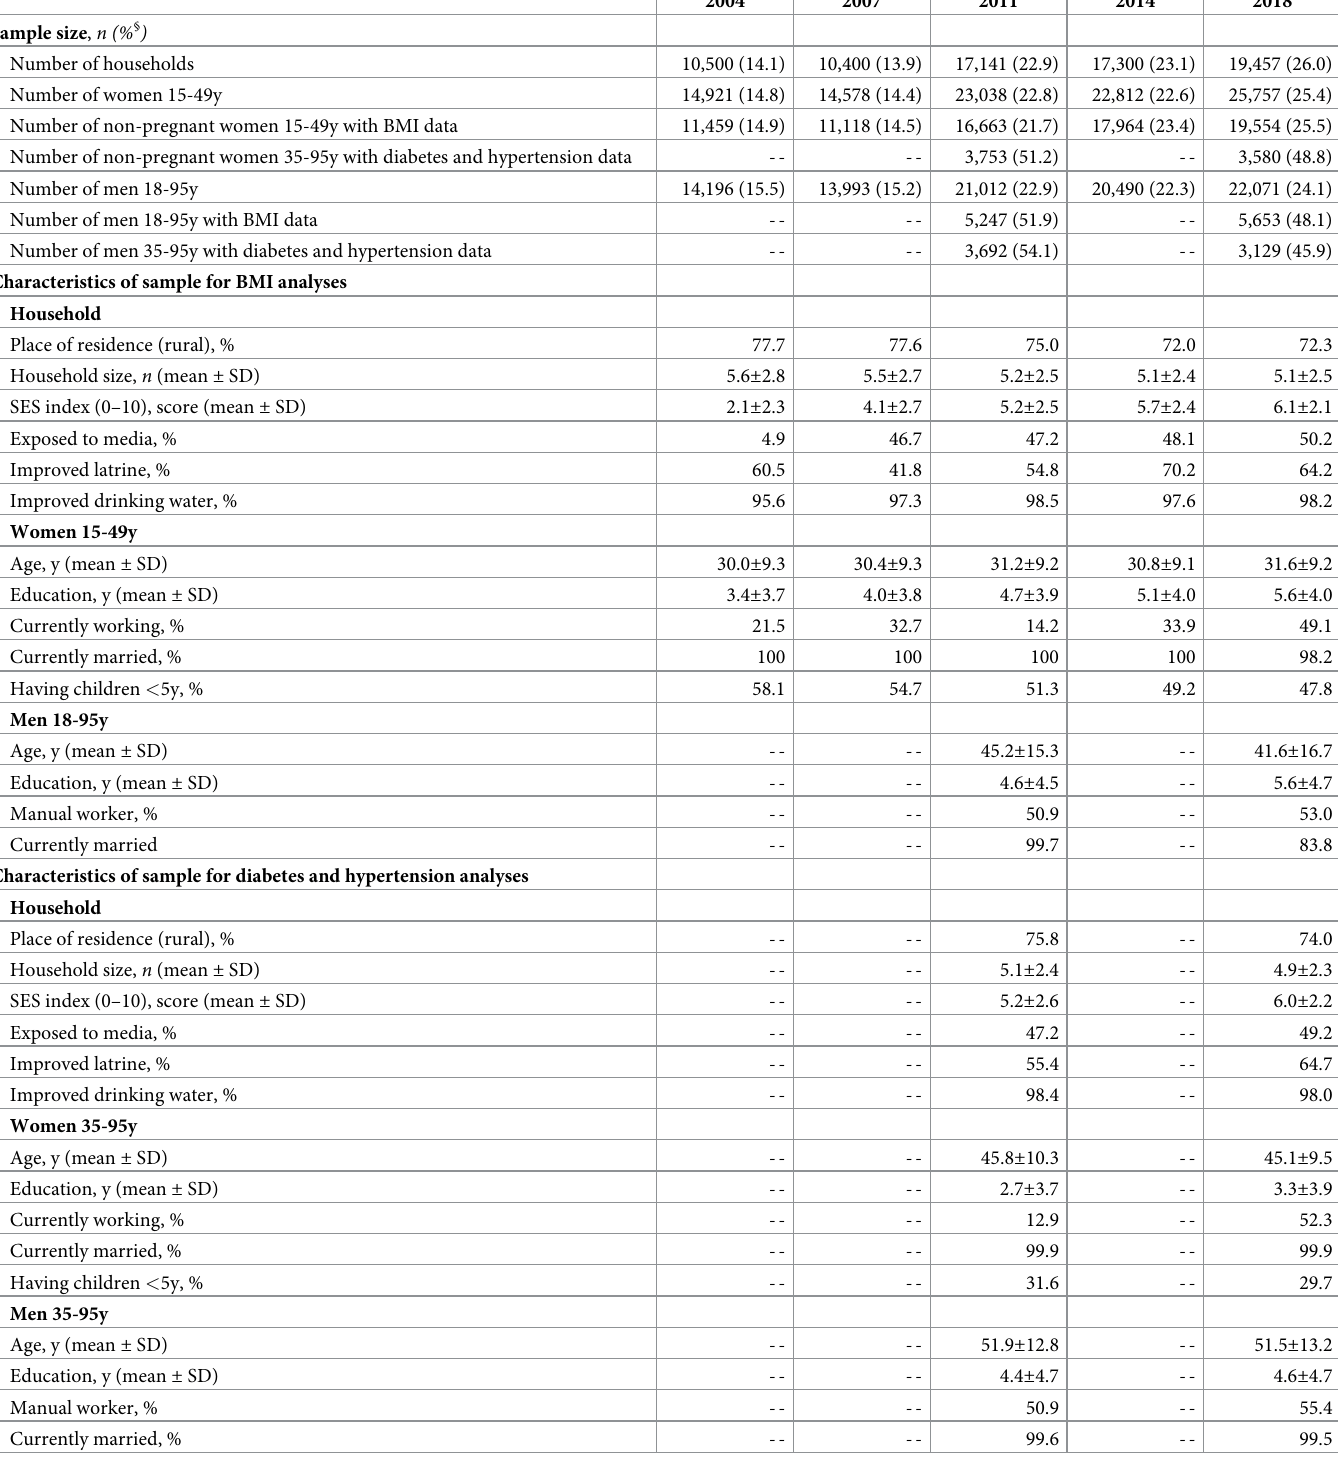
Table 1. Characteristics of households, women and men by survey round, Bangladesh